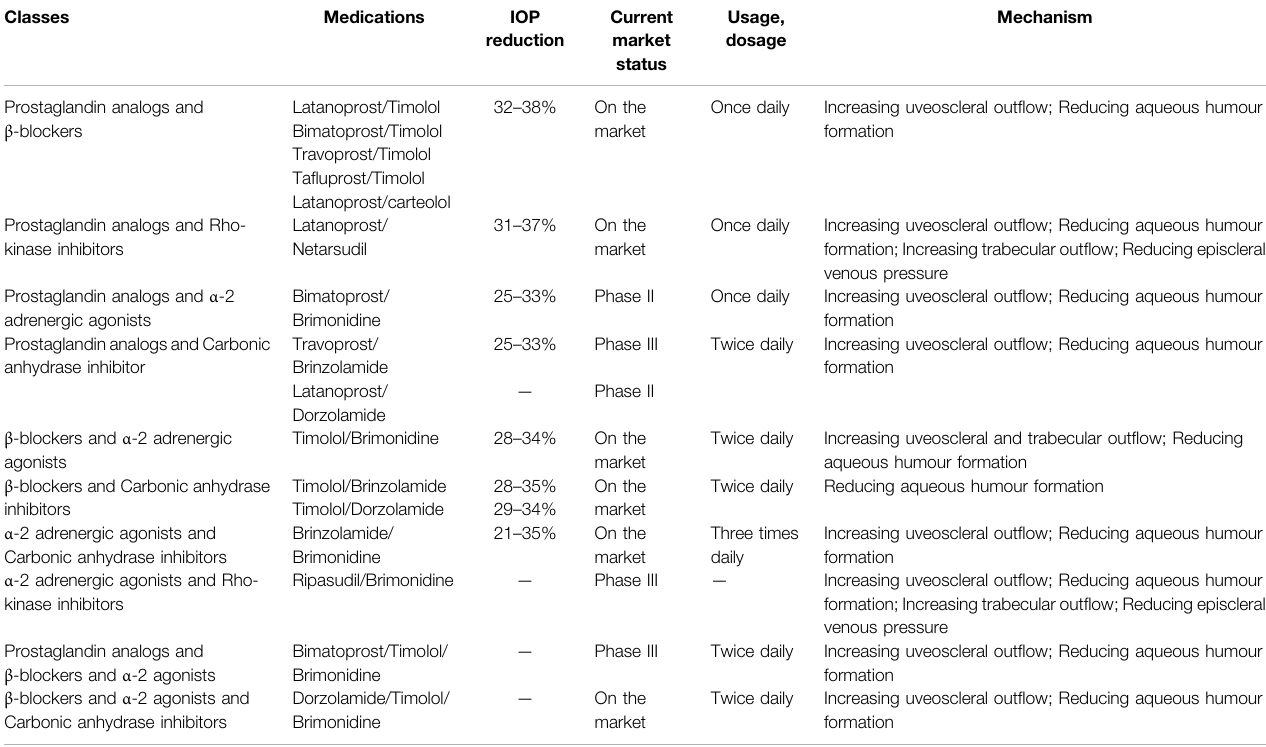
TABLE 5 | The class and list of fi xed-combination